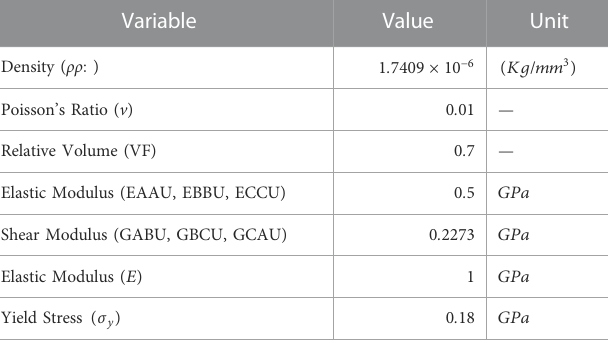
TABLE 2 Material property of battery ’ s foam (Sahraei, et al., 2012) (Kermani, et al., 2021). Variable Value